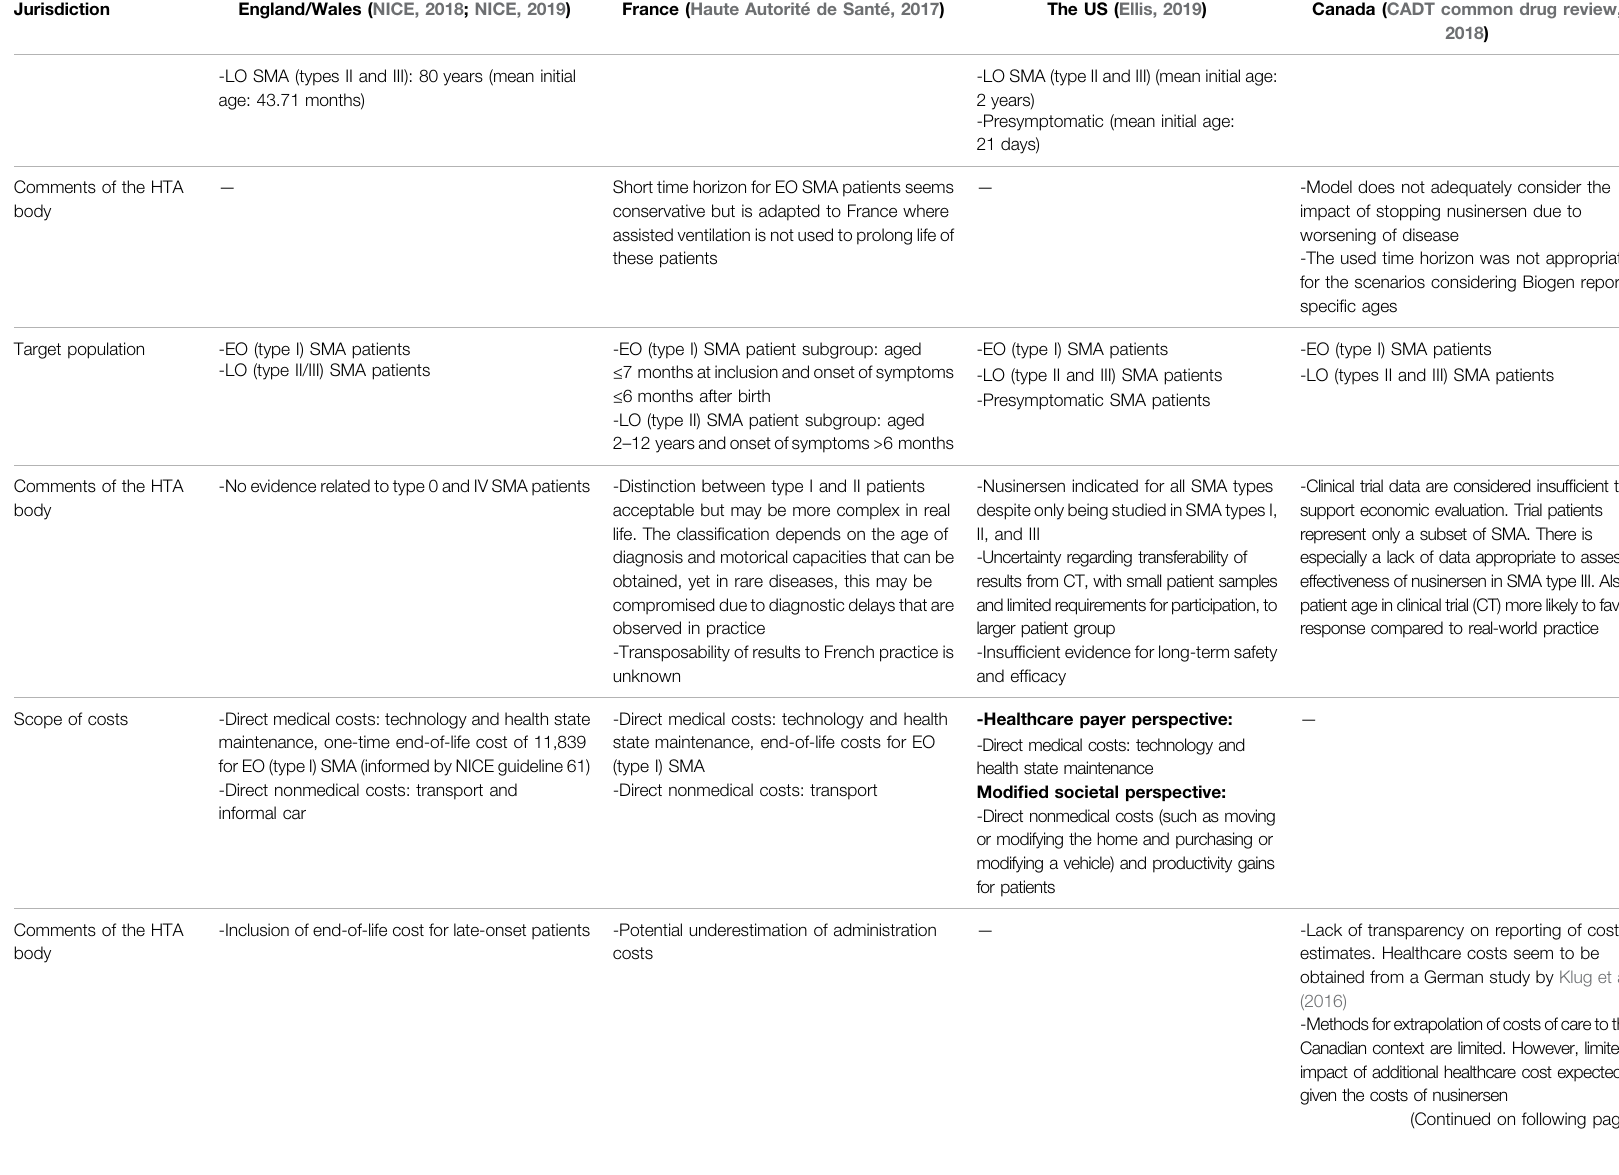
TABLE 2 | ( Continued ) Overview of the design of the economic evaluation of nusinersen in six European countries, the US, and